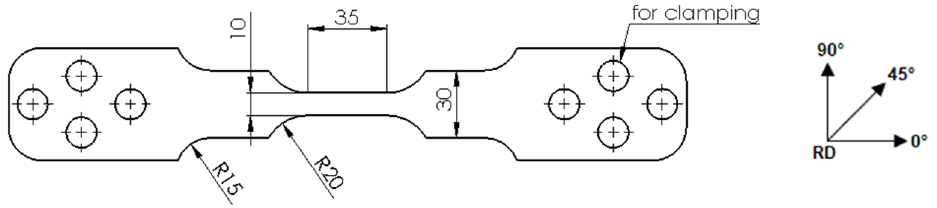
Figure 2. Sample dimensions and sampling directions for the uniaxial tensile tests (dimensions in mm).